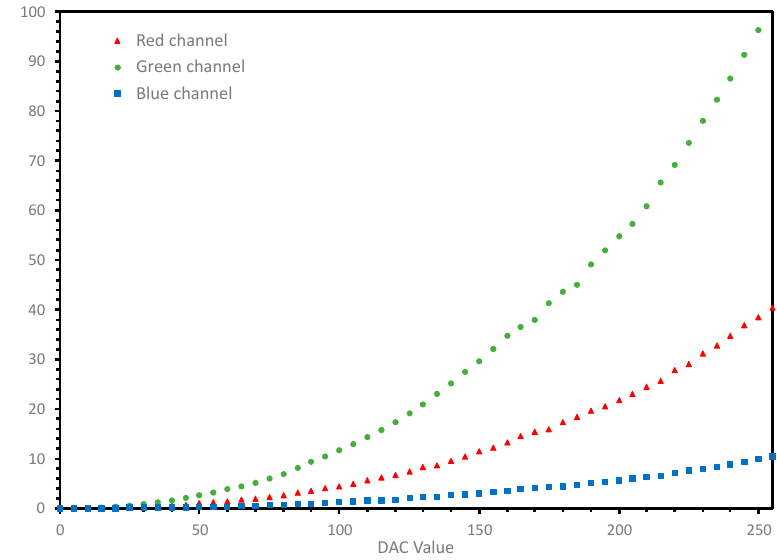
Figure 5. Relation between the DAC and luminance values for each RGB-independent channel.